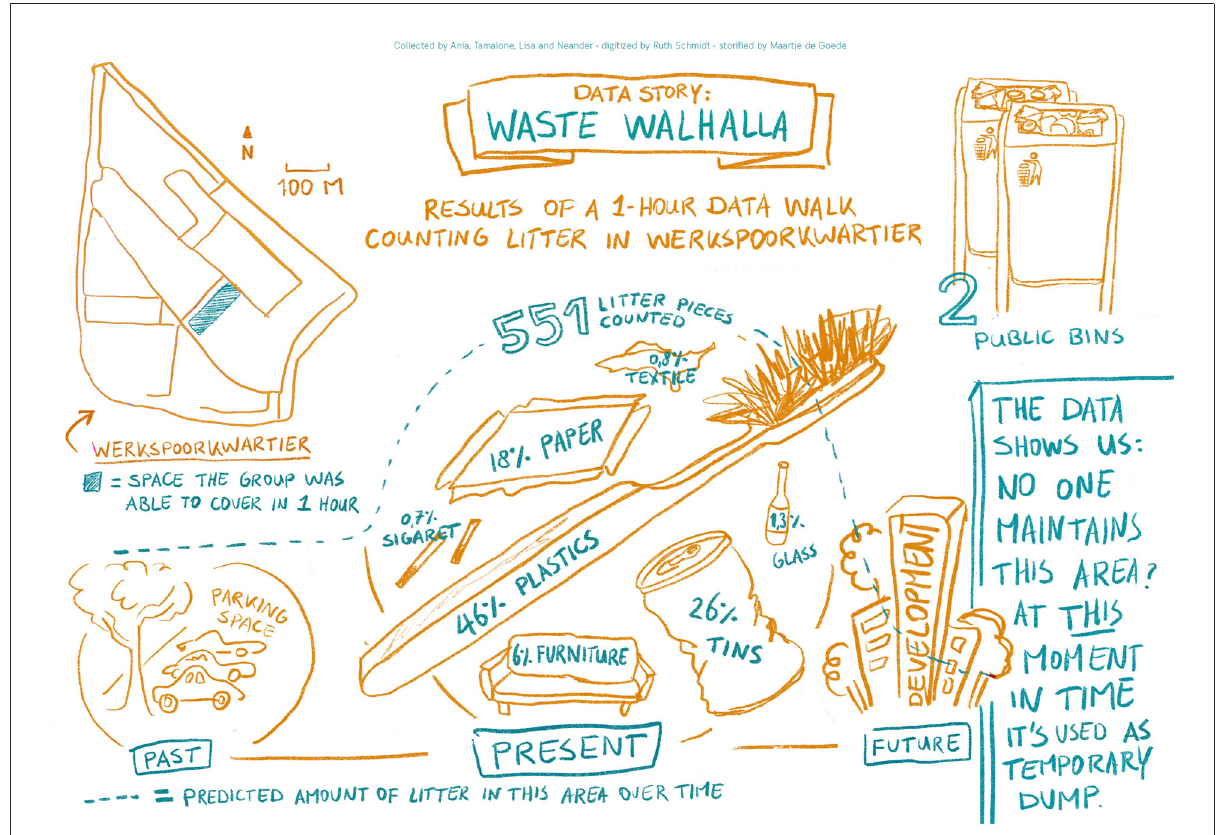
FIGURE7 Data story of the waste Walhalla done by Maartje de Goede to reflect on the findings of the data